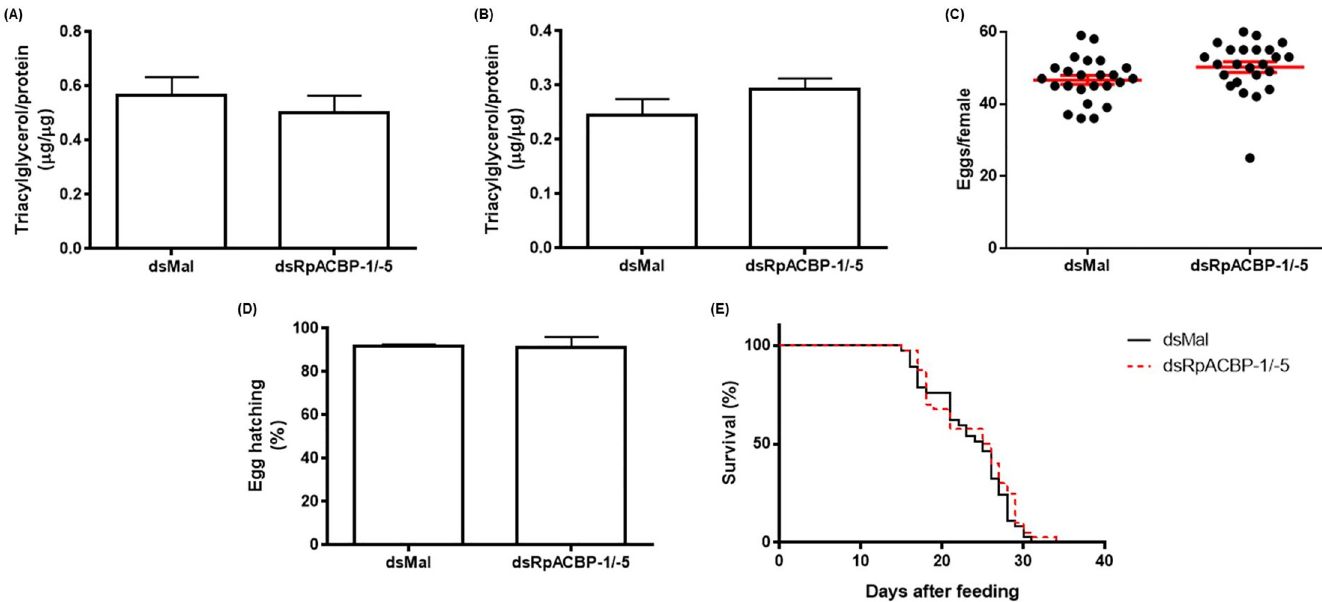
Fig 9. RpACBP-1 / RpACBP-5 double knockdown does not affect lipid accumulation, reproduction or lifespan. Adult fasted females were injected with a mixture of dsRNAs containing 1 μ g of dsACBP-1 plus 1 μ g of dsACBP-5 (dsRpACBP-1/5), or with 2 μ g of dsMal, used as a control. The insects were fed three days after the injection. The symbols and bars indicate means ± SEM. The fat body (A) and oocytes (B) were collected on the seventh day after feeding, and the TAG content was determined. p > 0.05 by Student’s t -test, n = 11–14. (C) Oviposition was monitored throughout the days after feeding. p > 0.05 by Student’s t -test, n = 24. (D) Eggs were collected on the different days of the oviposition cycle. The total number of hatched eggs in each experimental group was determined. p = 0.9358 by χ 2 test, n = 1205. (E) After feeding, insects were monitored daily. p > 0.05 by Log-Rank test, n = 24.